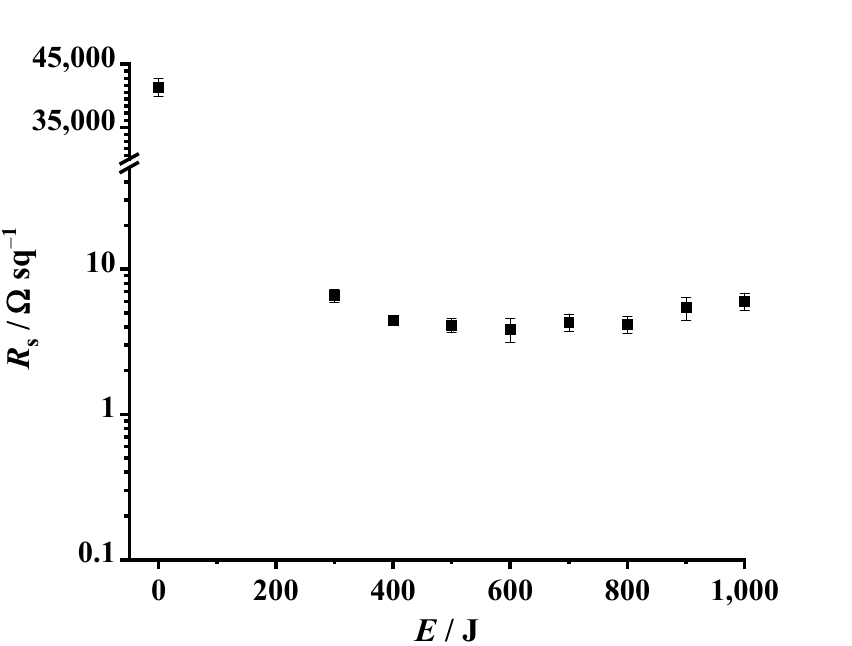
Figure 10. The sheet resistance of the printed silver film on a glossy paper substrate; the error bars represent standard deviation ( n = 6).